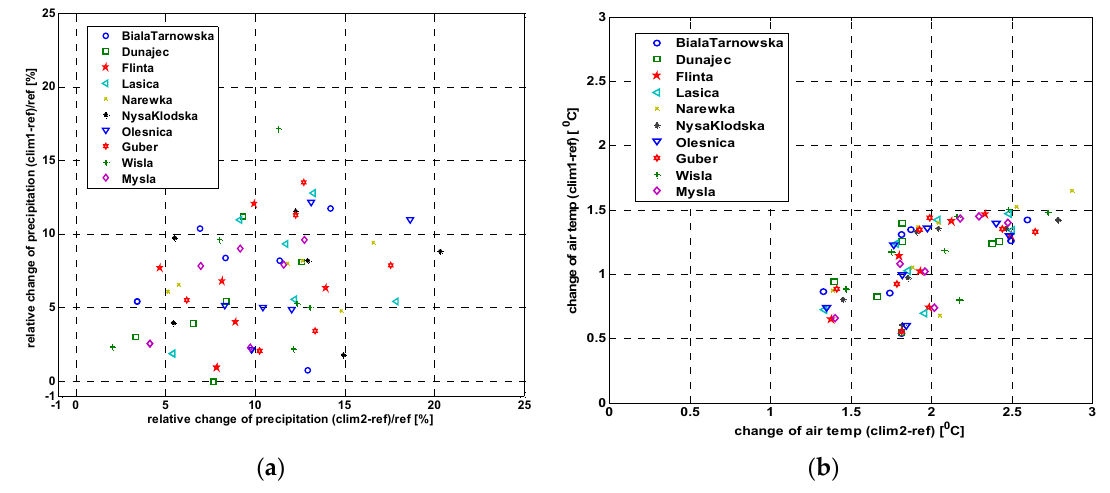
Figure 5. Estimated absolute changes in mean annual air temperature (°C) ( b ) and relative changes in mean annual sum of precipitation (%) ( a ) between two future periods (2021–2050 and 2071–2100) and reference period for seven climate models and ten catchments.